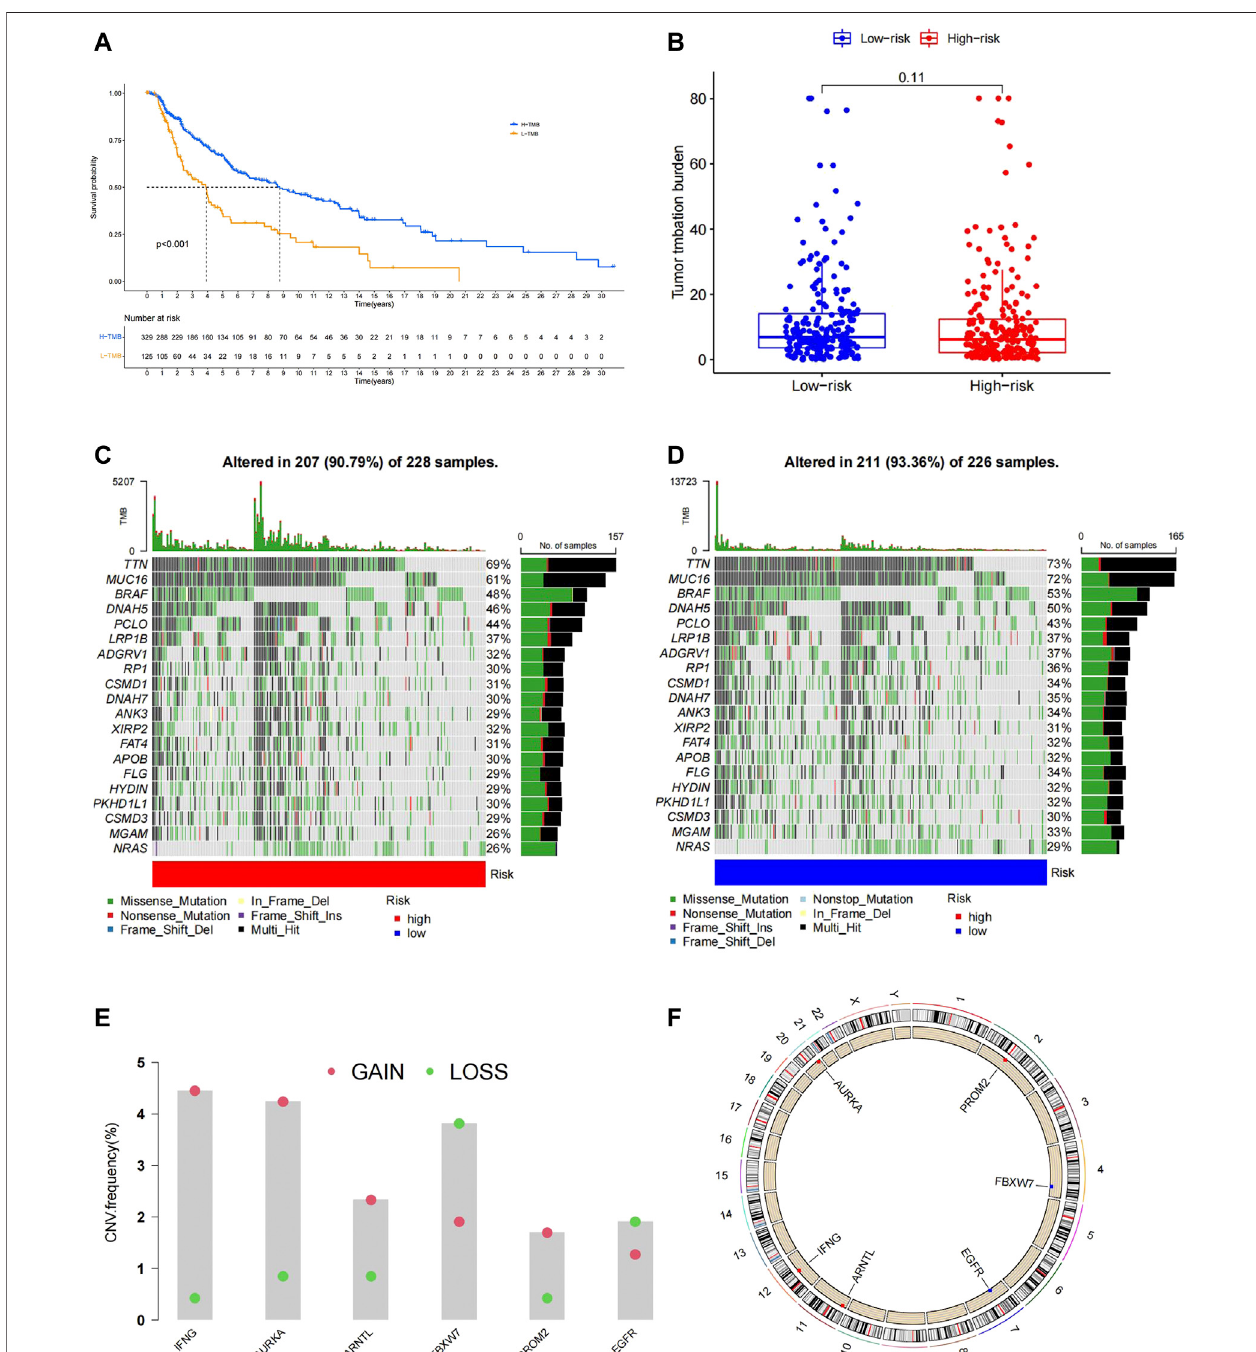
FIGURE 5 | (A) Patients with high TMB had a longer OS. (B) No signi fi cant difference in total TMB between the high- and low-risk group. (C,D) High-frequency mutated genes are ranked based on the mutation frequency, patients in the low-risk group showed higher mutation frequency. (E) Analysis of CNVs, the six prognostic FRGs exhibit different degrees of gain and loss in CNVs in melanoma. (F) Position of the six model genes on